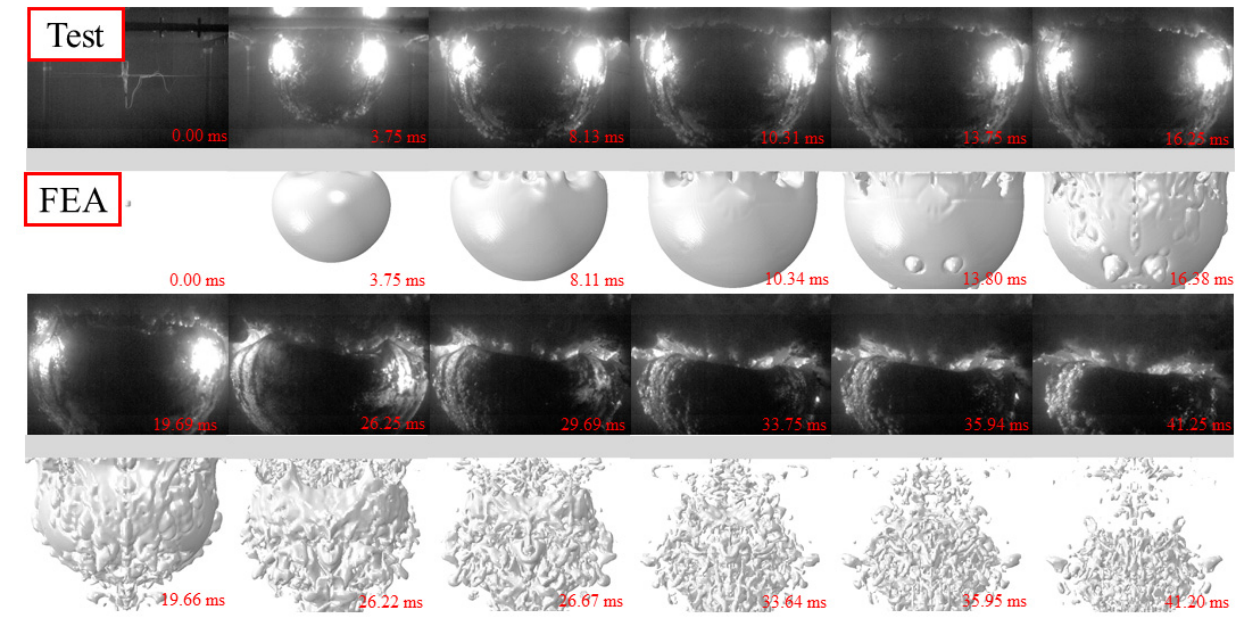
Figure 5. Whole process of underwater explosion for 10 g TNT.